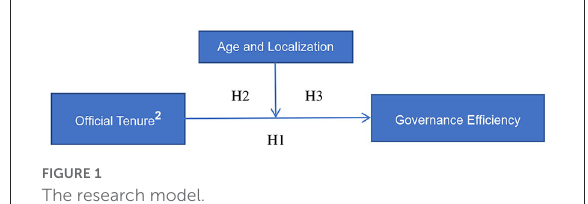
FIGURE1 The research model.